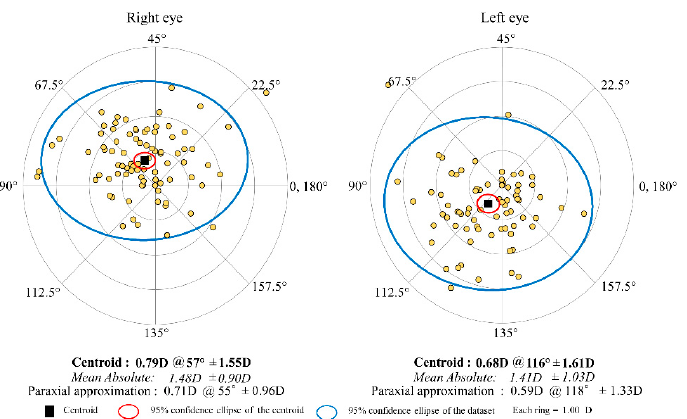
Figure 6. Graph showing the objective refractive SIA of trabeculectomy with double angle plots in the right and left groups.